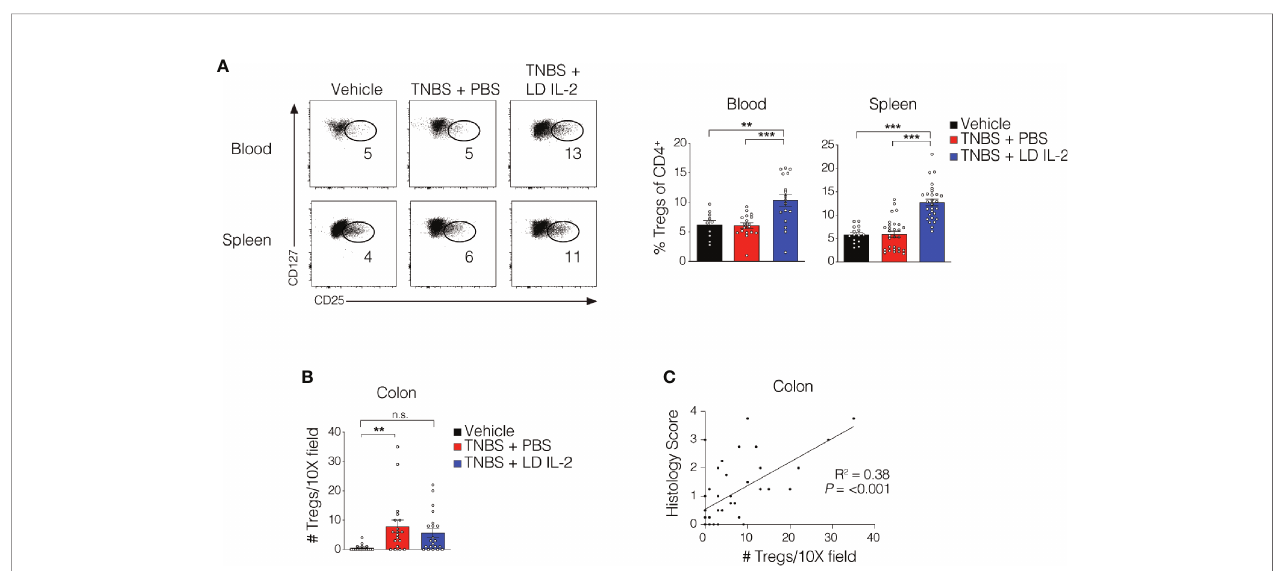
FIGURE 2 | T reg cell expansion in peripheral compartments following low-dose (LD) interleukin-2 (IL-2). (A) Representative fl ow cytometry dot plots of human T reg cells of CD4 + in blood and spleen (left) with quanti fi ed data (right). (B) Quanti fi cation of FOXP3 + cells via immunohistochemistry in the colonic lamina propria. (C) Correlation between T reg cell number and histology score in colon (R 2 = 0.38, P < 0.001). Data were pooled from three independent experiments and results were expressed as mean ± SEM. ** P < 0.01, *** P < 0.001; n.s., not signi fi